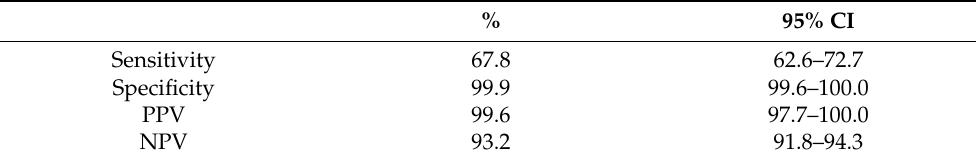
Table 2. Diagnostic performance of the rapid antigen test in the study population.